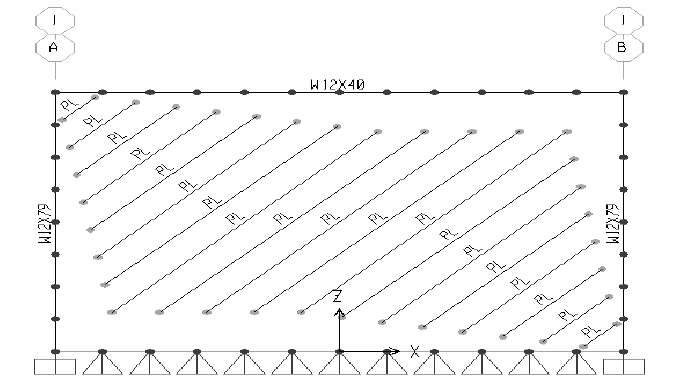
Fig. 4. Analyzed model of laboratory sample of Driver in software.